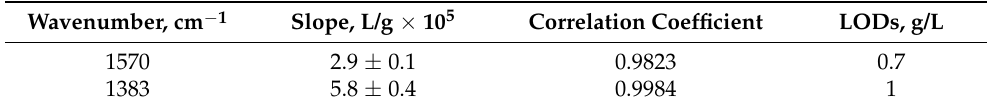
Table 6. Quantification of humate (Powhumus) by the bands 1560 and 1383 cm − 1 without baseline correction ( n = 10, p = 0.95).